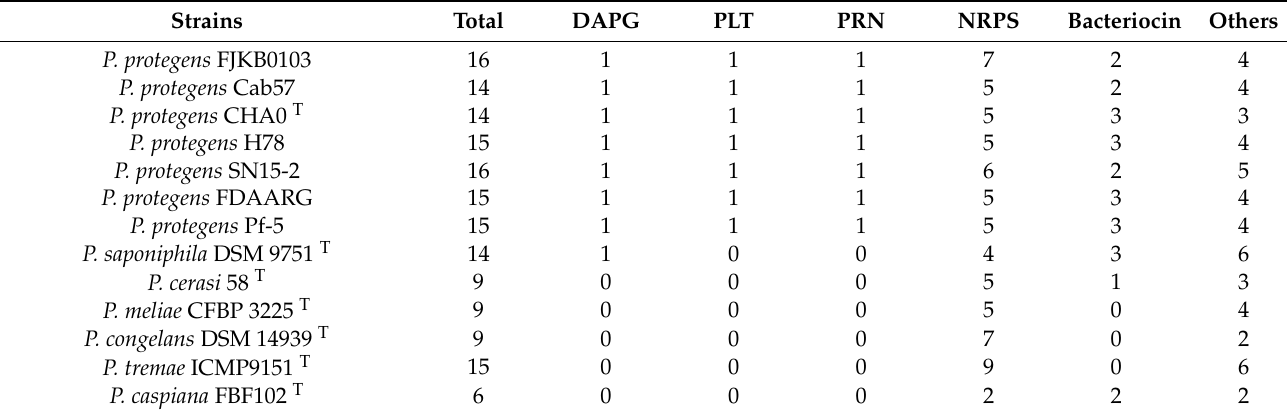
Table 3. Secondary metabolite and antibiotic gene clusters in P. protegens FJKB0103 and related strains predicted by antiSMASH a